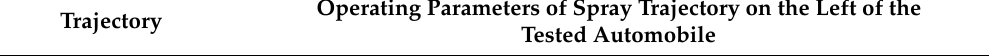
Table 2. Operating parameters of the spray painting trajectory on the left.